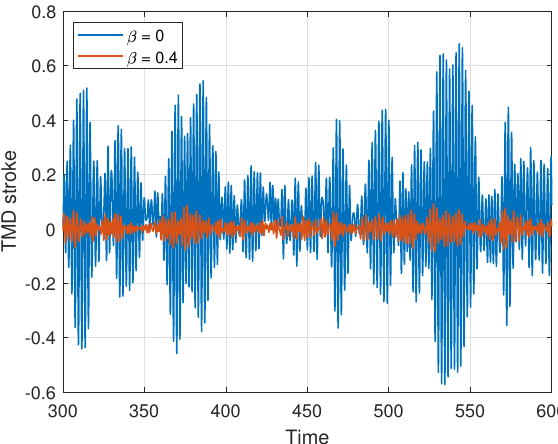
Figure 14. Tower fore-aft damper